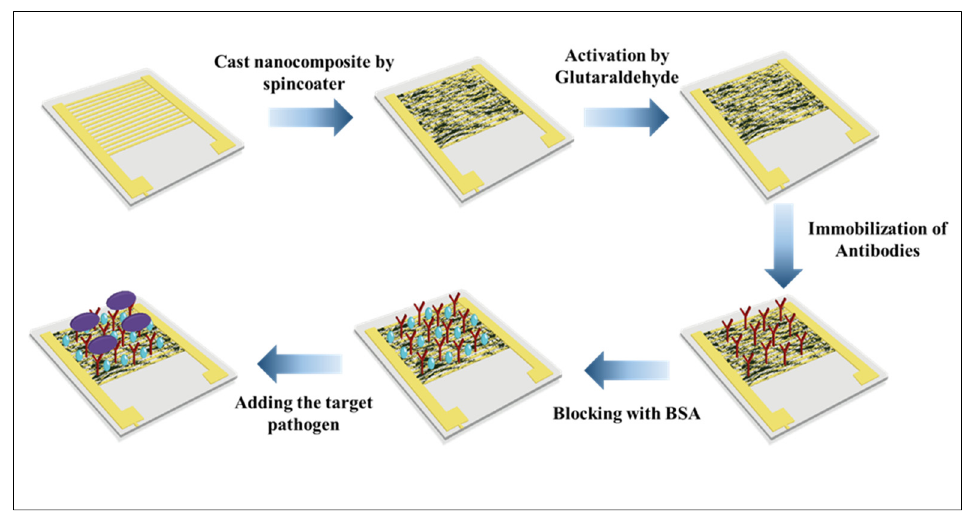
Figure 1. Schematic diagram of sensor’s fabrication.